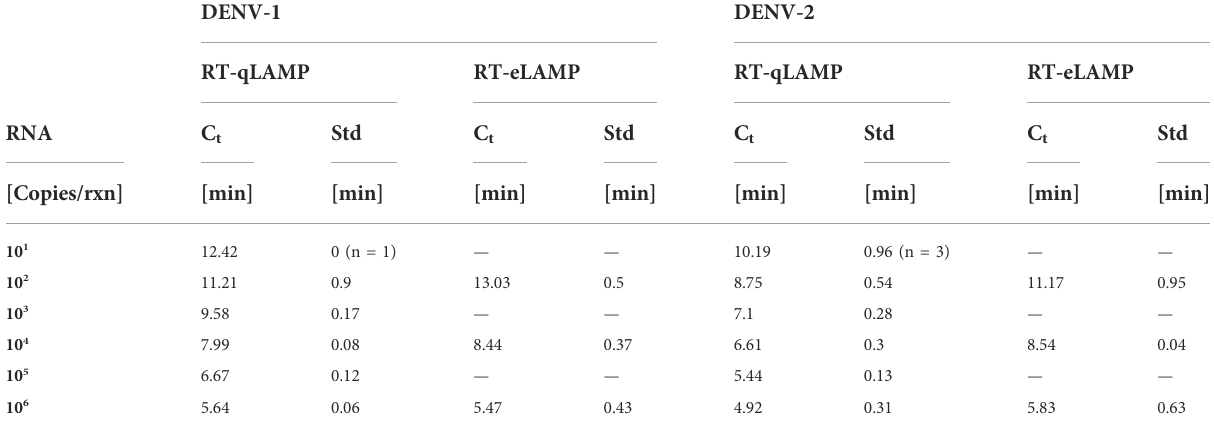
standard deviations below 1 min. Non-template controls (NTCs) were run in triplicates and no indication of non-speci fi c ampli fi cation or primer dimer was observed during the 25- min reaction time. Melting curve analysis (Section S2) was carried out to con fi rm assay speci fi city. Overall, these results validate the performance of the LAMP assays with our RT- qLAMP protocol.